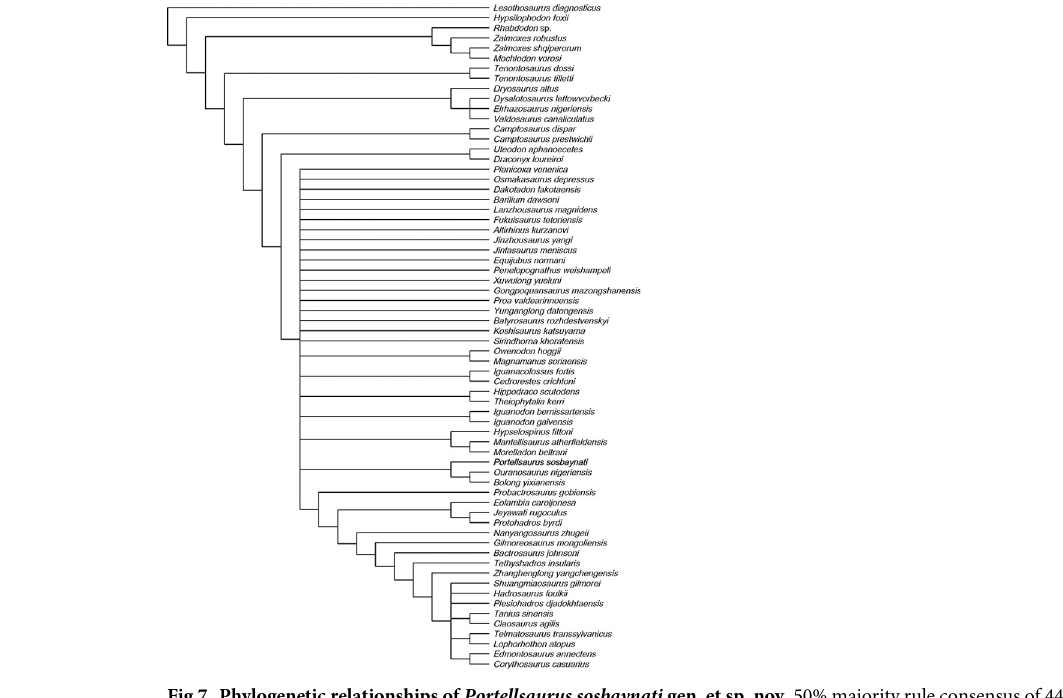
Fig 7. Phylogenetic relationships of Portellsaurus sosbaynati gen. et sp. nov. 50% majority rule consensus of 440 most parsimonious trees.